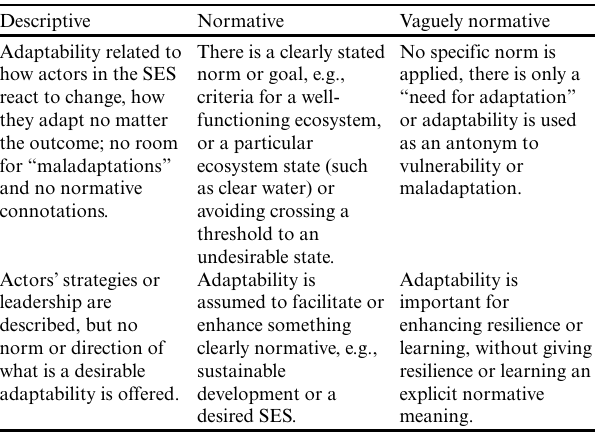
Table 2. Coding of research question 2, descriptive vs. normative. Each row represents sufficient but not necessary